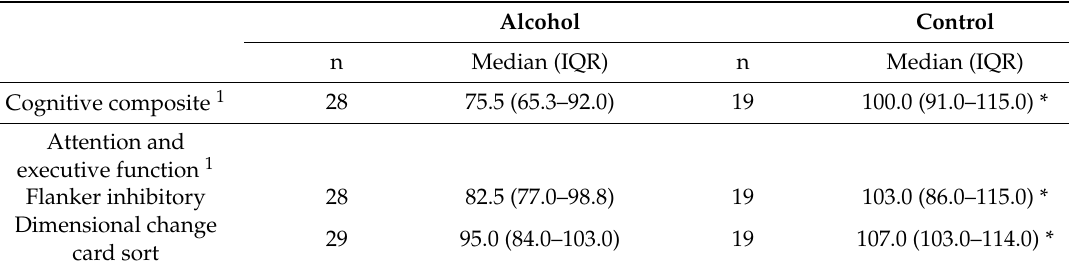
Table 3. Scores on selected measures of NIH toolbox cognition